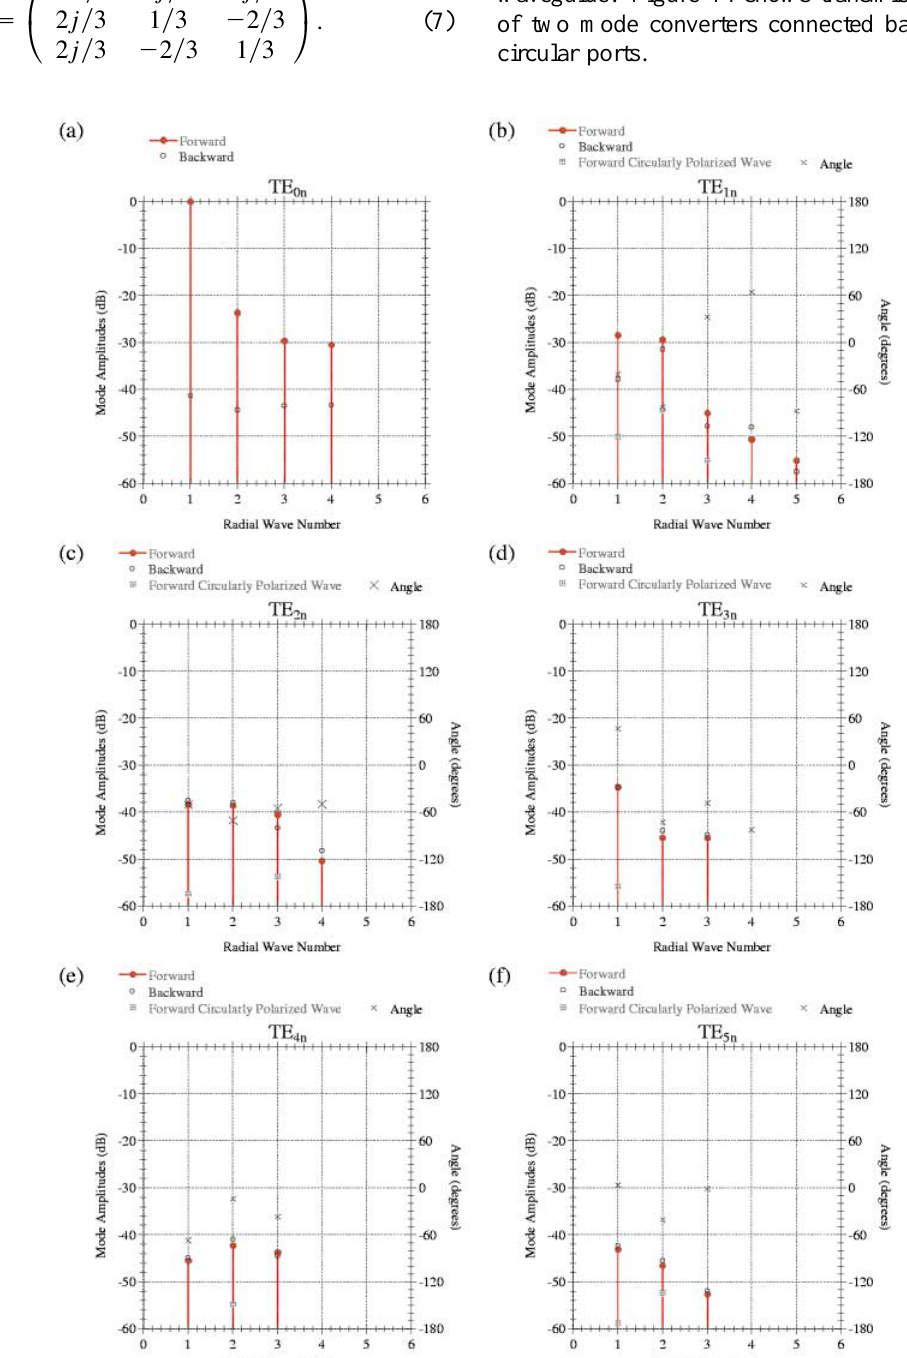
FIG. 15. (Color) Measured mode spectrum of the TE 01 mode transducer. The decomposition is done in terms of a linearly polarized component and a circularly polarized one. The angles in these graphs are the inclination angle of the linearly polarized field component with respect to the vertical